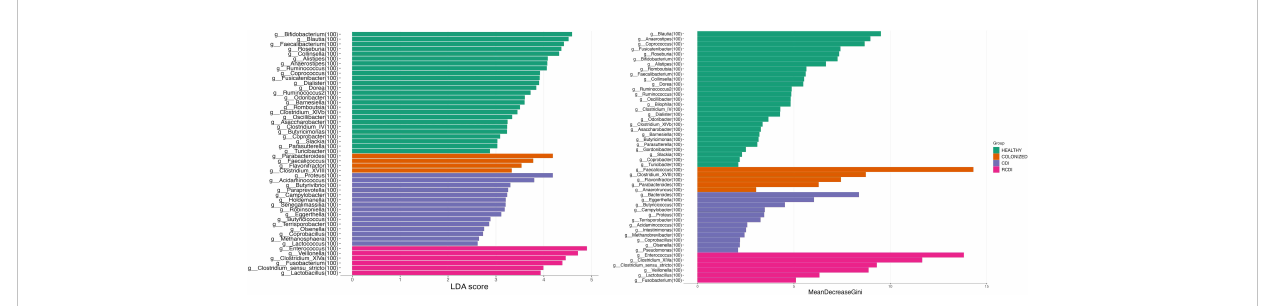
FIGURE 5 List of possible genera biomarkers that enable discrimination between groups. Left (Linear discriminant analysis (LDA). Right Random Forest (RF)). CDI, Clostridioides dif fi cile infection; NOCDI, Non C. dif fi cile diarrhoea; RCDI, recurrent CDI; Colonized, patients colonized with C. dif fi cile ; Healthy, Healthy subjects.